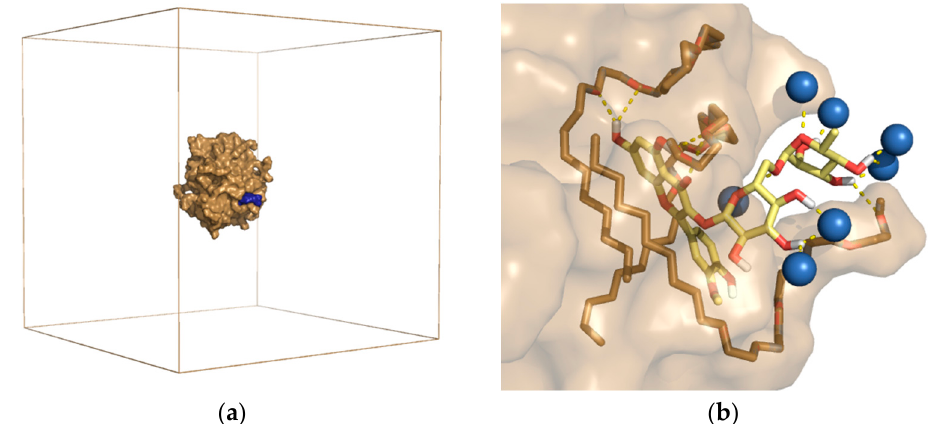
Figure 5. RNL5 micelle with adsorbed narcissin molecule after 100 ns of MD simulation. ( a ) shows the sand-colored micelle surface with blue-colored narcissin inside the simulation box. Water molecules are invisible. ( b ) Binding arrangement of narcissin (yellow) on the surface of RNL5 micelles. The water molecules (blue balls) and the surfactant (sand sticks) involved in the binding of the flavonoid are visible [10].